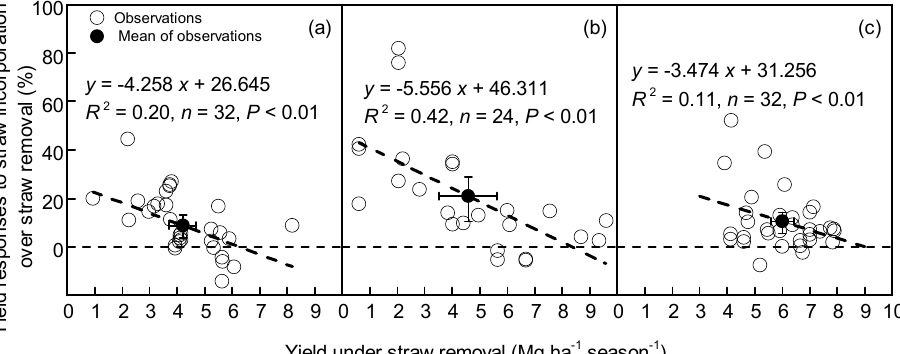
Figure 4. Relationships between crop yield responses to SI and control yield under SR for (a) wheat, (b) maize and (c) rice. Yield responses are expressed as the relative increase (%) compared with the control (SR). Error bars in horizontal and vertical directions represent 95% CIs of the control yield and yield responses, respectively.